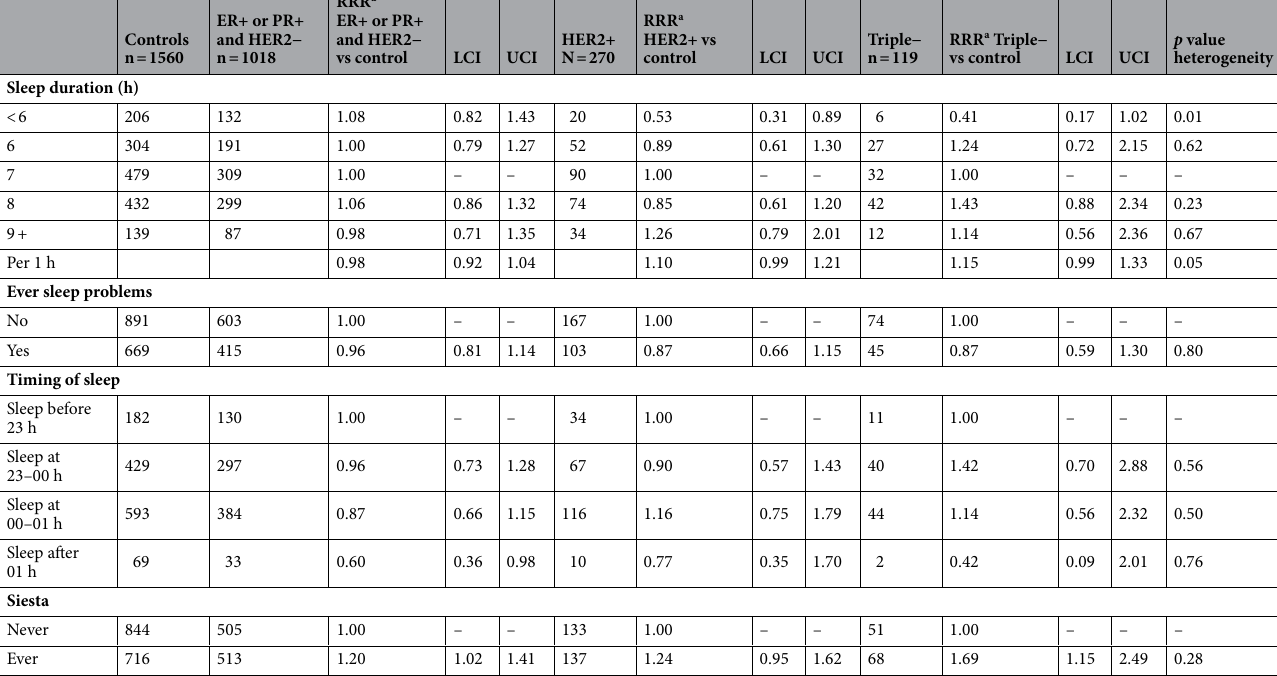
Table 3. Associations of selected habitual sleep characteristics and breast cancer risk by sub-phenotype, MCC-Spain, 2008–2013. Note the sum does not equal the total due to missing data. a Models adjusted for age, centre, education, socioeconomic status, cigarette smoking status, family history of breast cancer in first degree relatives, BMI, physical activity, alcohol consumption, parity, age at first child, oral contraceptive, hormone replacement therapy, age at menarche, menopausal status. Categories for missing values were created for family history of breast cancer in first degree relatives, alcohol consumption, and hormone replacement